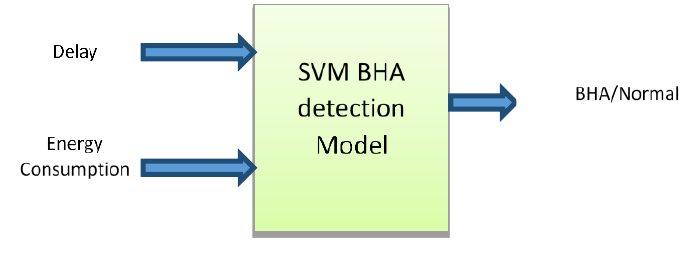
Figure 11. Block diagram of SVM.